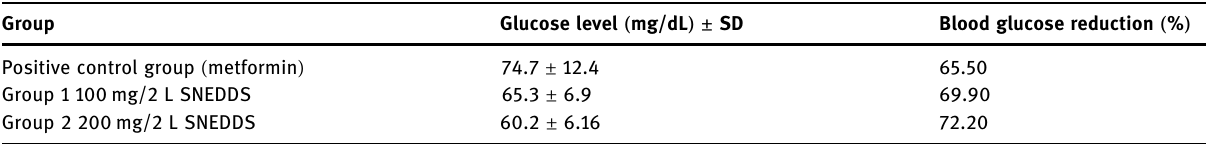
Table 3: Percentage of fasting blood glucose reduction of PLE SNEDDS